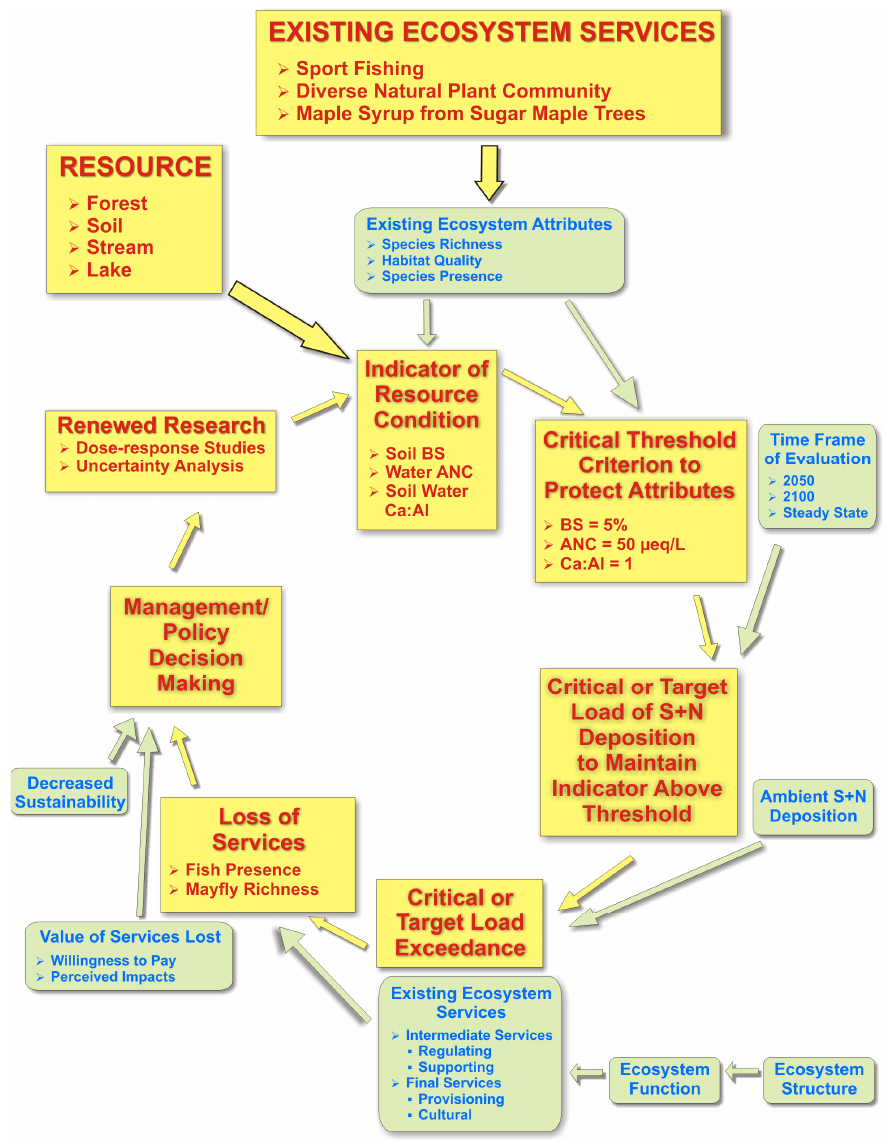
Figure 1. General conceptual model for assessment of acidification effects of atmospheric S and N deposition, incorporating the critical load and ecosystem service concepts. BS is soil percent base saturation; ANC is surface water acid neutralizing